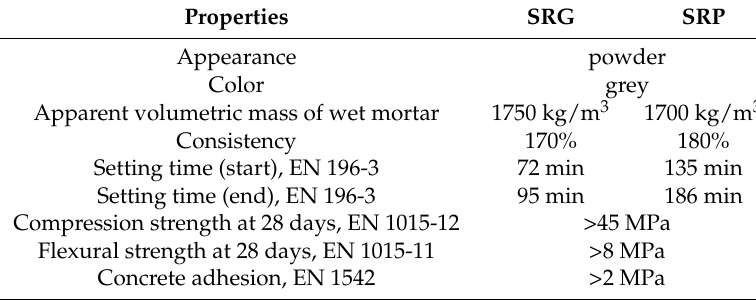
Table 3. Properties of the matrix used for the Steel Reinforced Grout (SRG) and Steel Reinforced Polymer (SRP) systems.